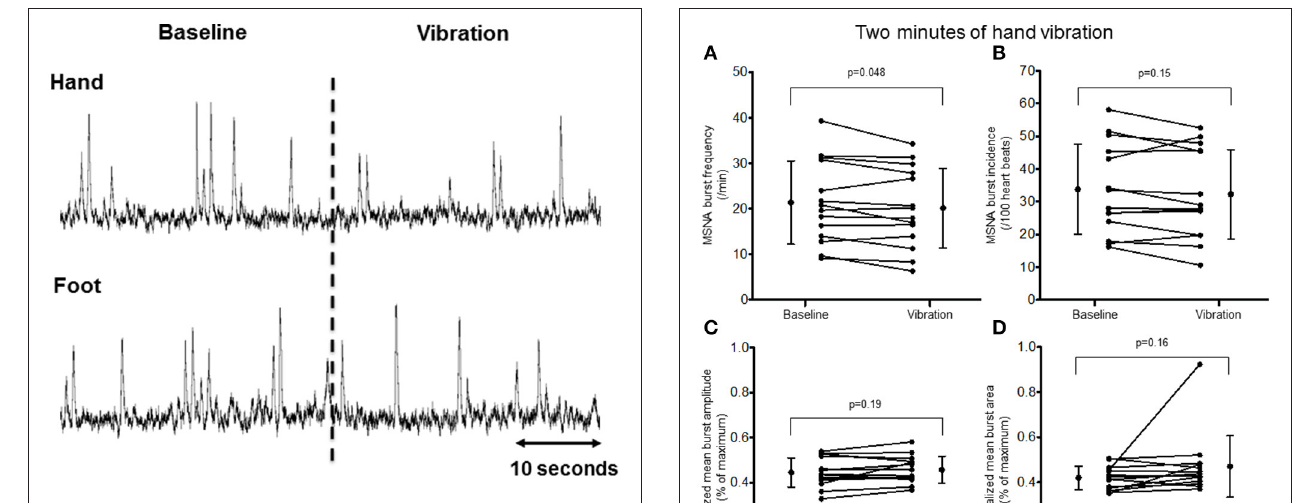
FIGURE 2 | Representative 60s integrated muscle sympathetic nerve activity (MSNA) tracings from one participant during the end of baseline and beginning of vibration in the hand and foot. The dashed line indicates the onset of vibration. p = 0.048) in 10/14 participants, but did not alter burst